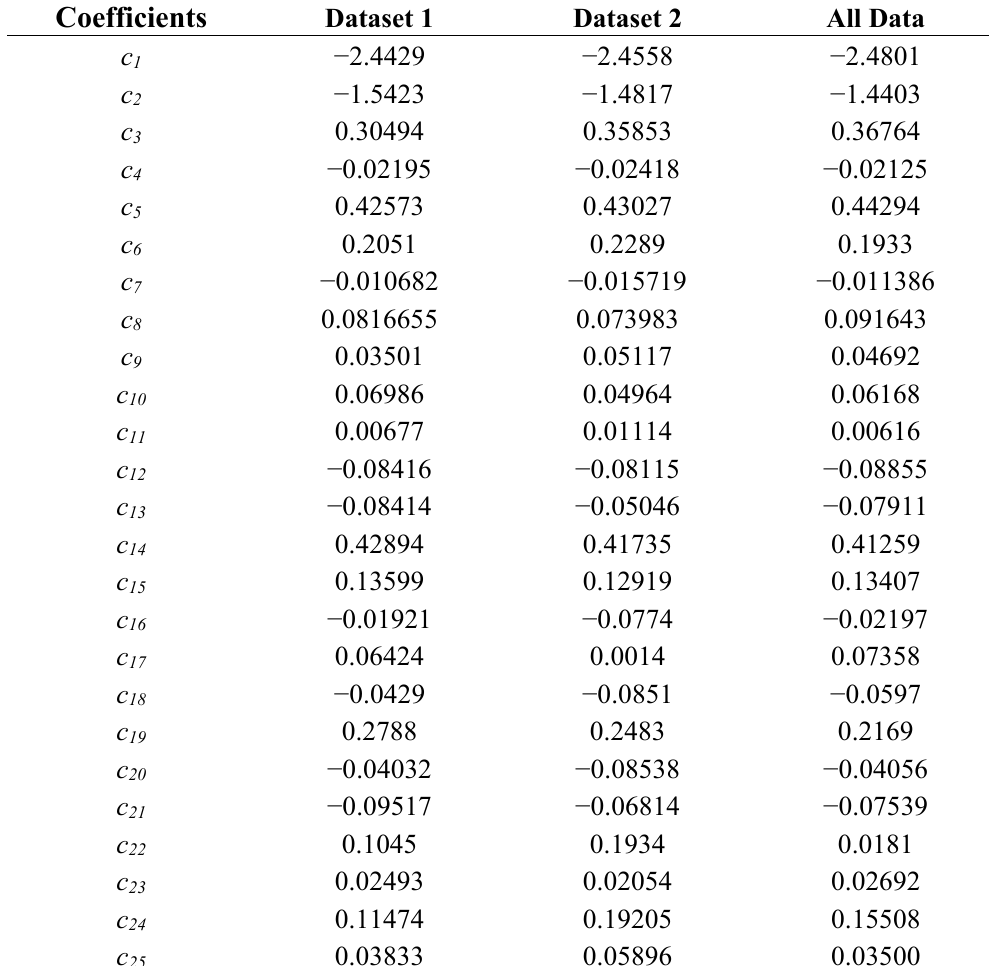
Table1. Tuned coefficients of the SIRX-MOD